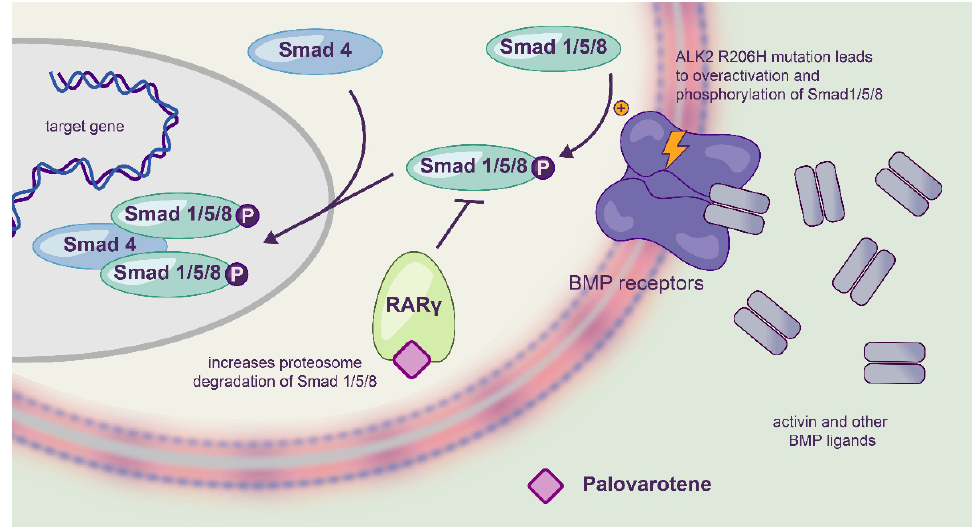
Figure 4. Schematic representation of the mechanism of action of palovarotene.